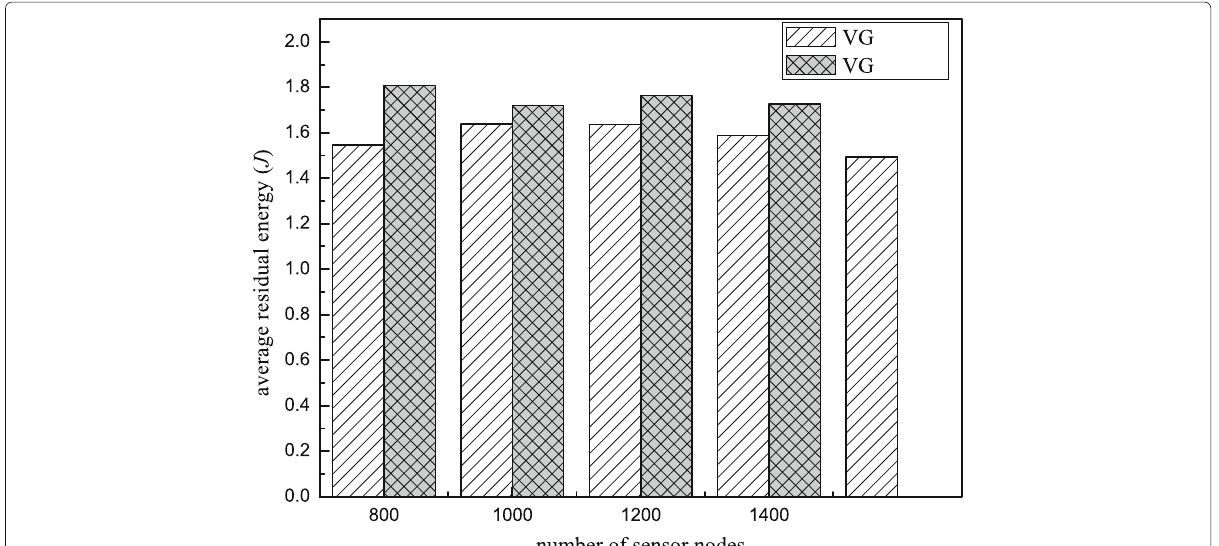
Fig. 13 The comparison of VGDD and VGDCA-C in average residual energy. It indicates that the VGDCA-C could work longer when the same energy was consumed, which further means that the VGDCA-C had higher energy utilization